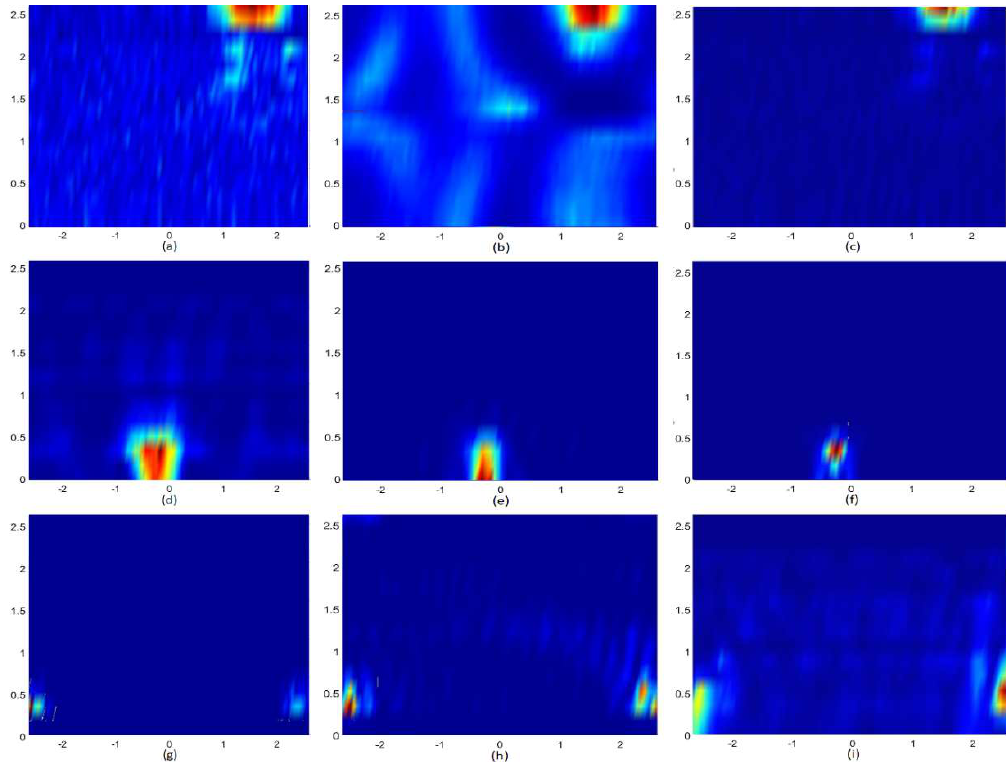
Figure 11. Boundary imaging. ( a ) upper boundary of 2 GHz; ( b ) upper boundary of 4 GHz; ( c ) upper boundary of 6 GHz; ( d ) lower boundary of 2 GHz; ( e ) lower boundary of 4 GHz; ( f ) lower boundary of 6 GHz; ( g ) left and right border of 2 GHz; ( h ) left and right border of 4 GHz; ( i ) left and right border of 6 GHz.